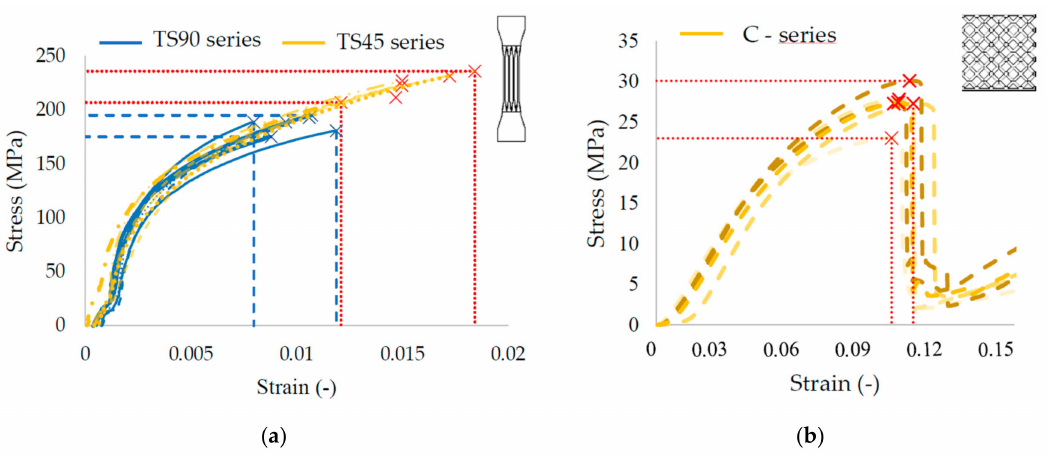
Figure 10. ( a ) Quasi-static stress-strain curves of the struts tensile specimens; and ( b ) Quasi-static stress-strain curves of the compression specimens. Table 4. The dimensions of the tensile specimen specimens (multi-struts tensile specimens TS-series; bulk tensile specimens TB-series).